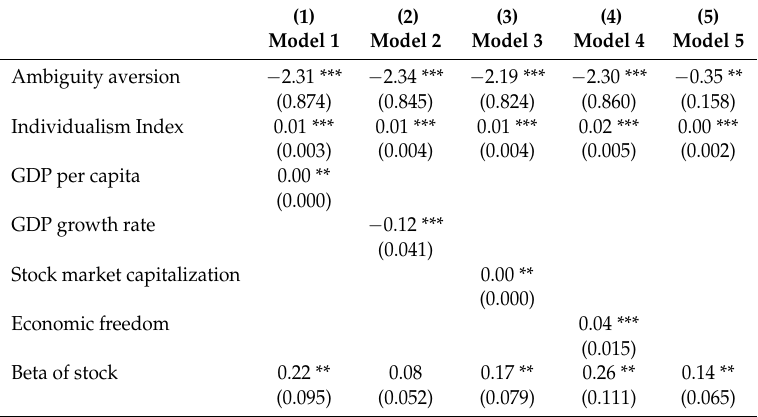
Table 6. The equity premia, ambiguity aversion and the individualism